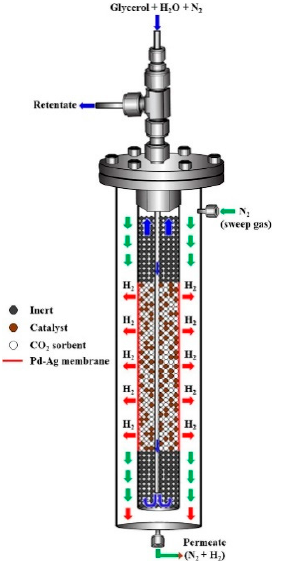
Figure 12. Sorption-enhanced membrane reforming of glycerol for hydrogen production with CO 2 capture, reproduced from [43].